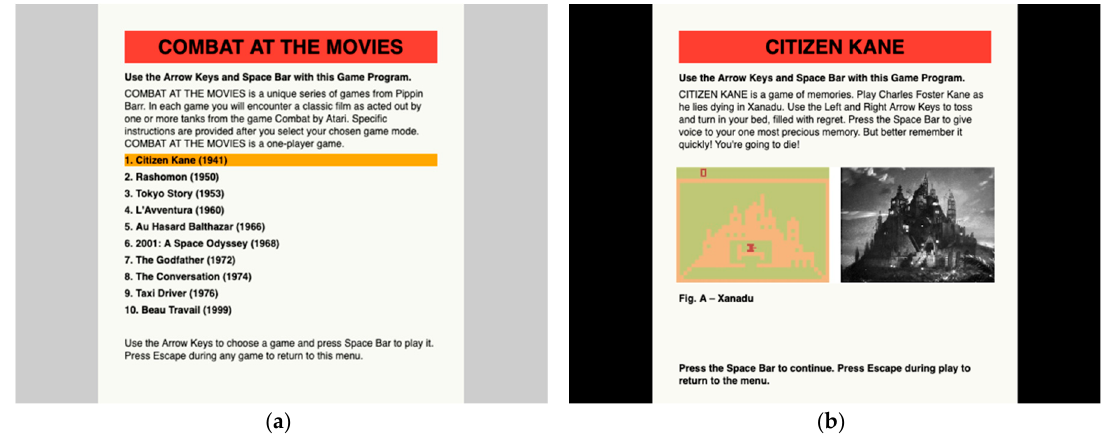
Figure 3. Instruction screens for Combat at the Movies . ( a ) The main menu with general description of the project; ( b ) the specific instructions for the Citizen Kane adaptation.